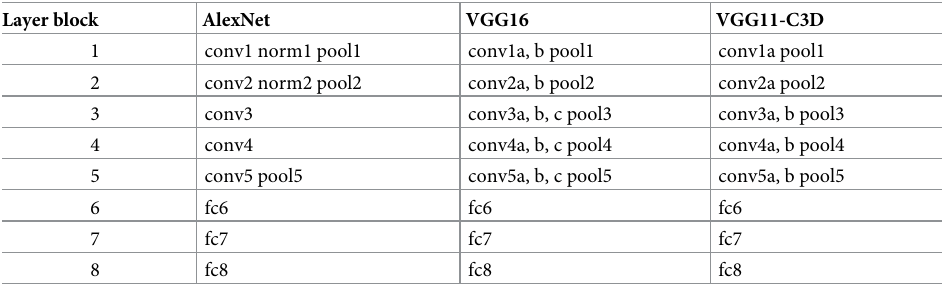
conv : convolutional layer, suffixes a, b, or c are used if a block contains multiple conv layers; norm : local response normalization; pool : max pooling operation; fc : fully connected